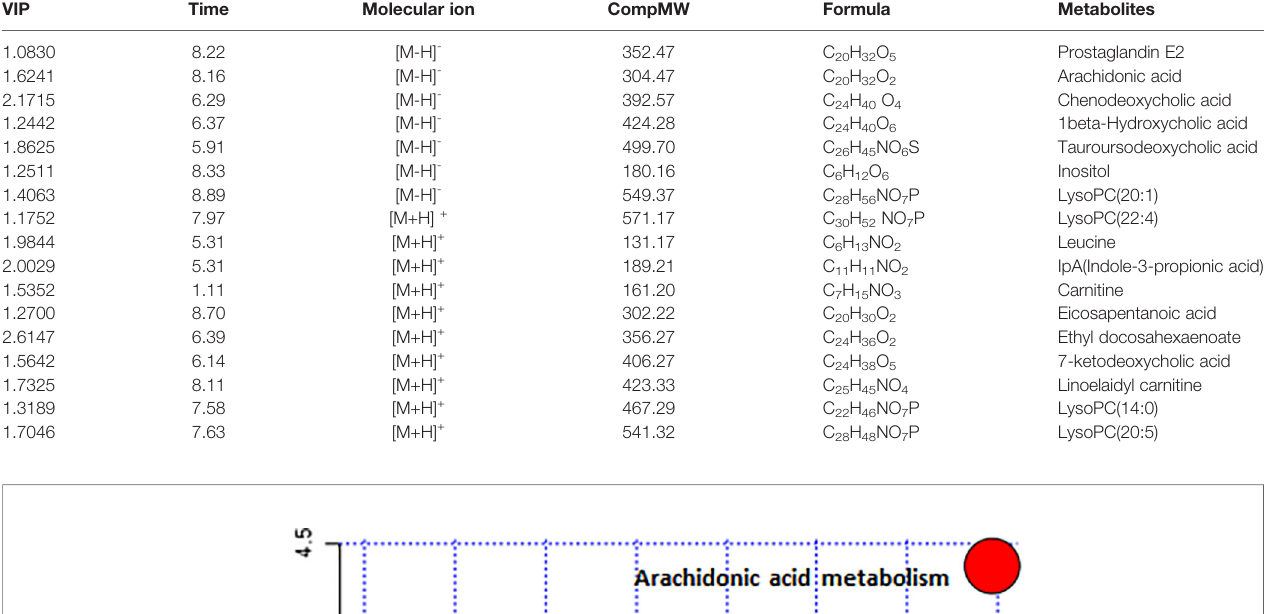
TABLE 3 | Endogenous metabolites identi fi ed in the serum of rats included in this study. VIP